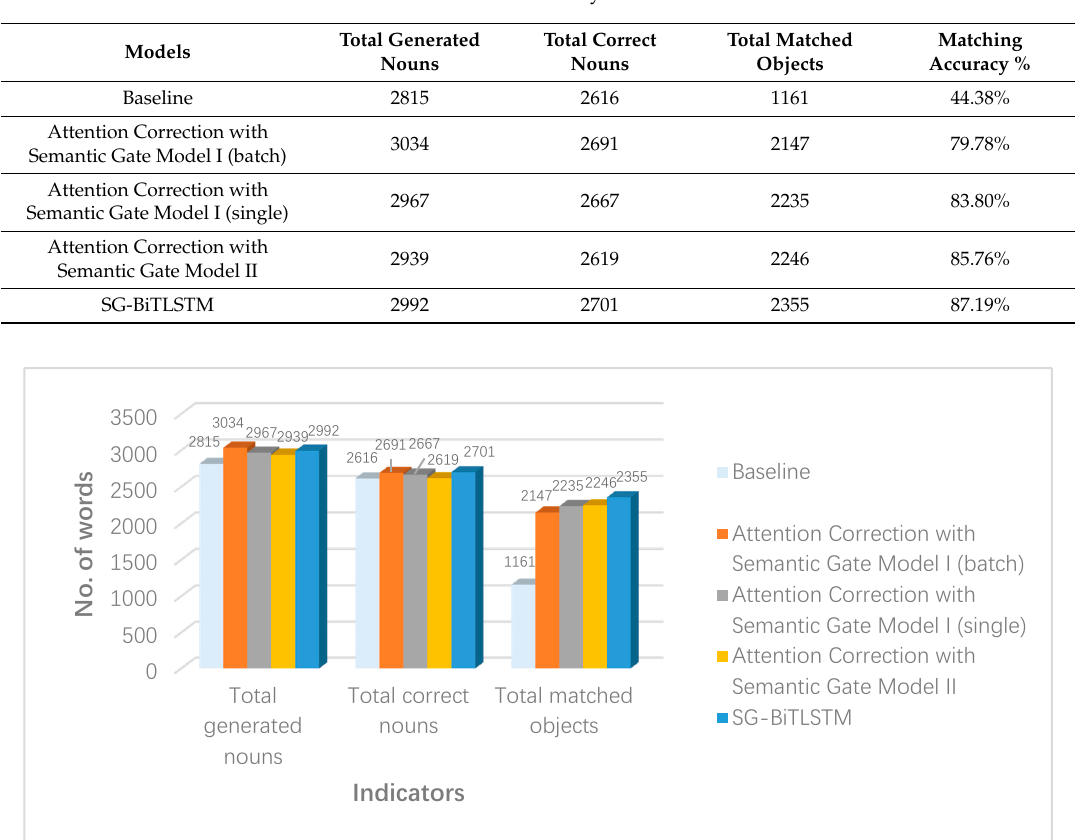
Table 4. Locations accuracy of the models.